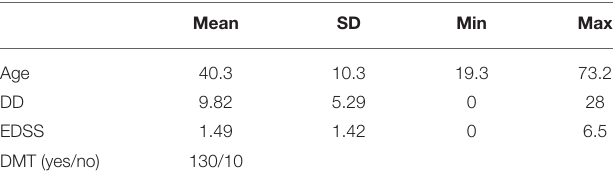
TABLE 1 | Clinical data of the